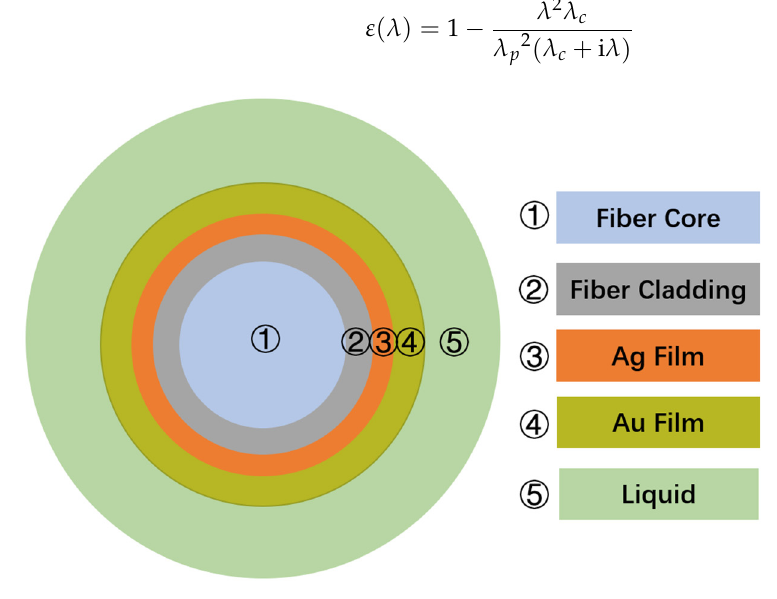
Figure 1. Cross section of the optical fiber temperature sensor.